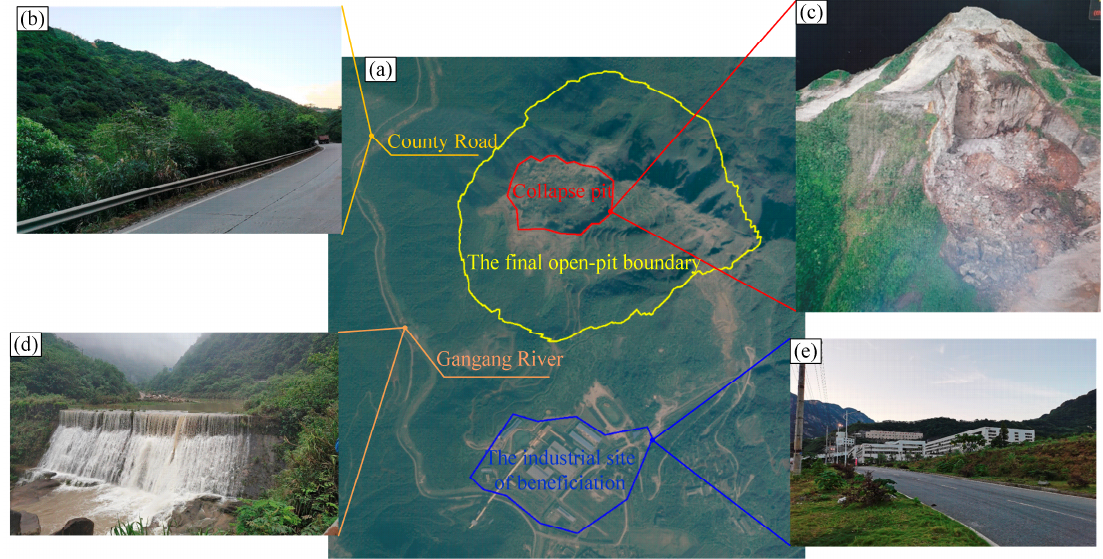
Figure 1. The open ‐ pit mine and surroundings areas: ( a ) the satellite view of the surface of the open ‐ pit mining area; ( b ) county road; ( c ) collapse pit model; ( d ) Gangang River; ( e ) the industrial site of beneficiation.